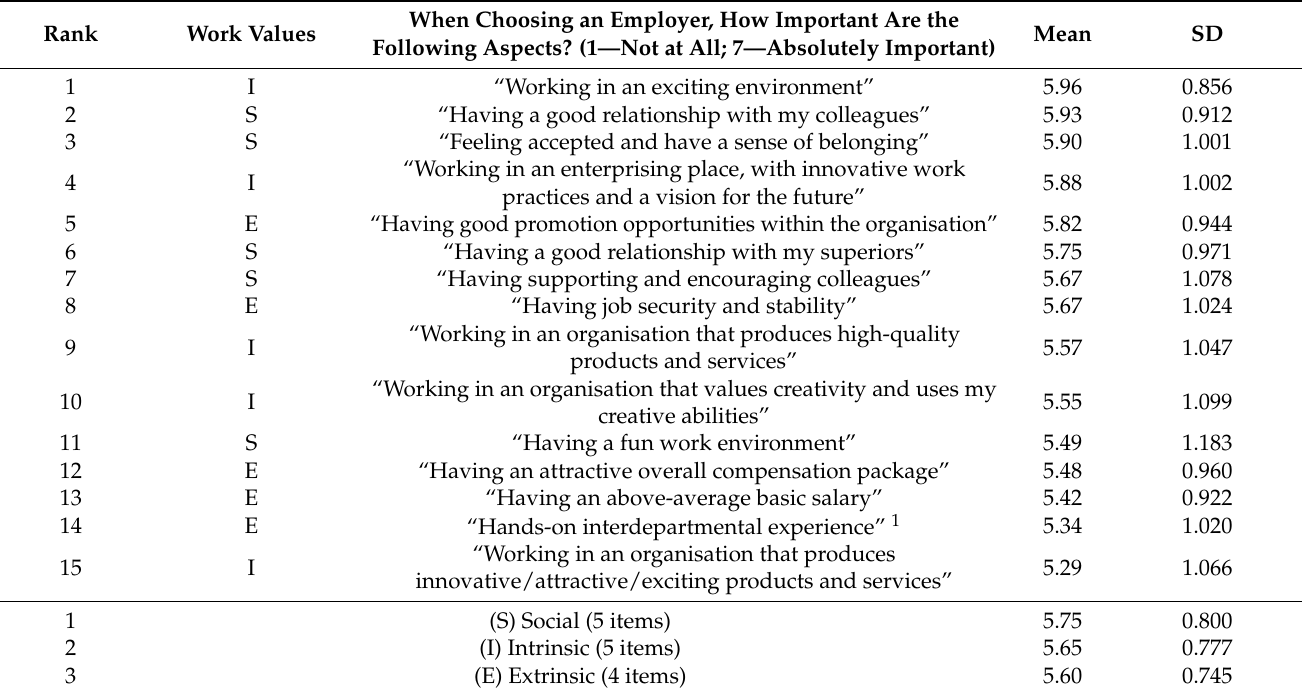
Table 1. Work values